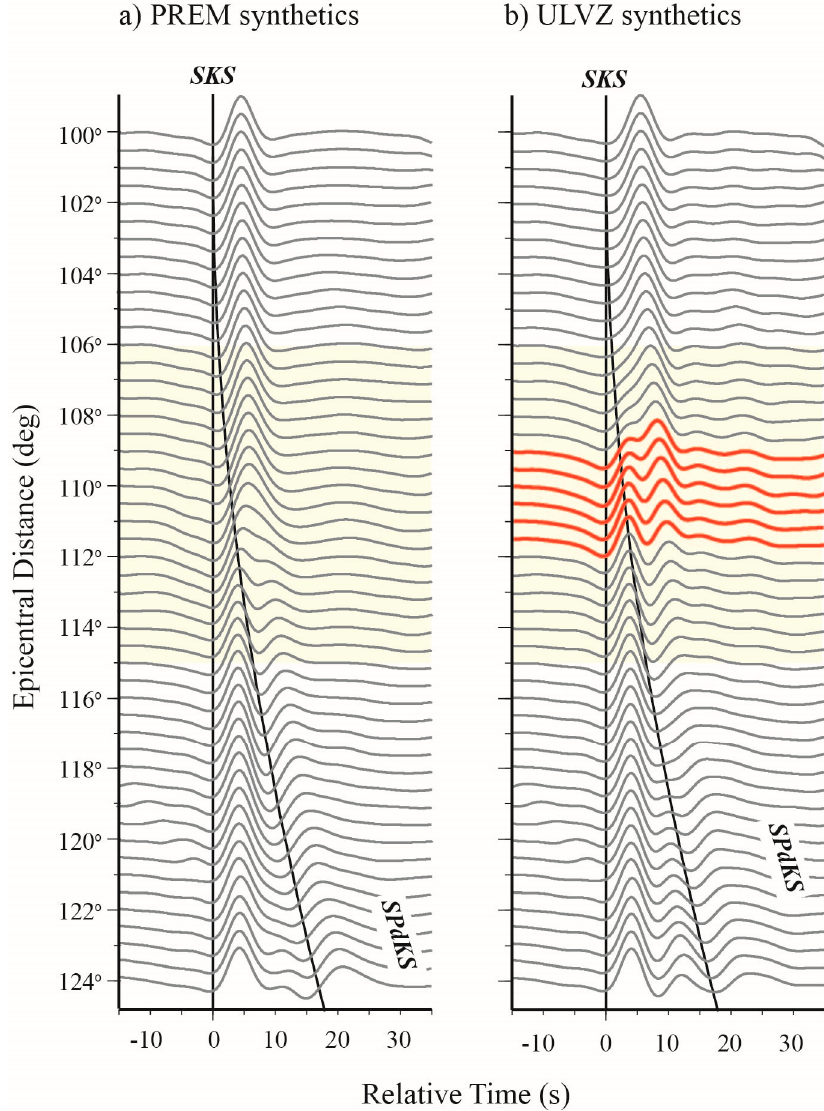
Figure 2. ( a ) Synthetic seismograms for the PREM model. ( b ) Synthetic seismograms for a ultra-low-velocity zone (ULVZ) model with a thickness = 20 km, S-wave velocity reduction of 45%, P-wave velocity reduction of 15%, length in the great circle arc direction of 3°. The ULVZ boundary begins 13° away from the source in the angular direction. ULVZ synthetics that are characteristically anomalous in waveform shape are highlighted in red. All traces are radial component, displacement seismograms. Traces are aligned in time on the SKS onset and normalized to the maximum amplitude in the trace.